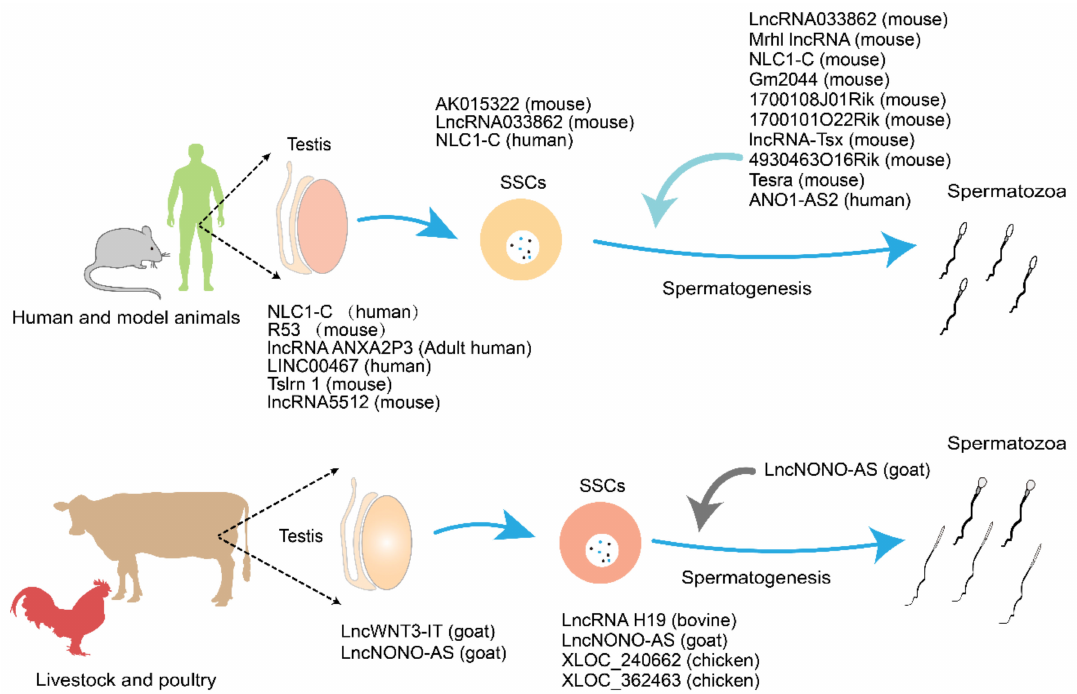
Figure 5. Long noncoding RNAs (lncRNAs) with possible potential as therapeutic biomarkers in